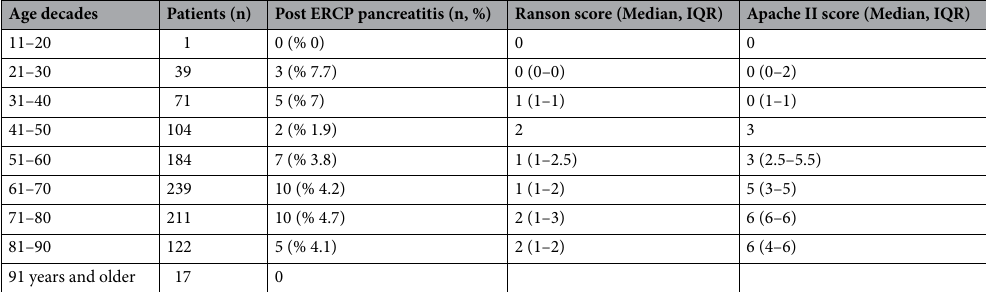
Table 2. Patients compared to see post ERCP pancreatitis ratio and prognosis and divided into their age decades.